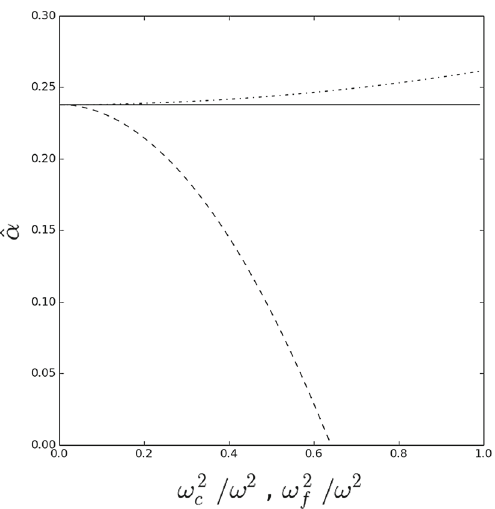
/ω 2 , ω 2 /ω 2 for SIS (continuous line), NSIS Fig. 15 Plot of ˆ α vs. ω 2 c f (dashed line), and PGC (dot-dashed line). We used Λ = 0 . 1, r c = 10, r 0 = 10, sin χ = 1, s = 0 . 03, and b =